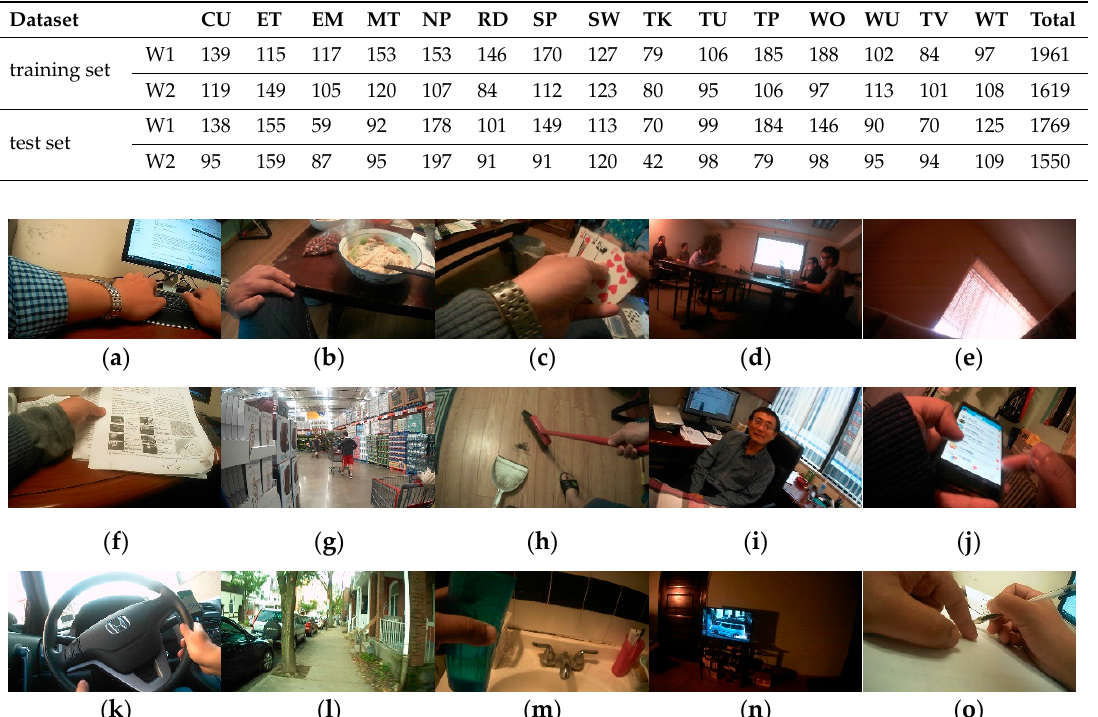
Table 3. The egocentric activities and their corresponding categories in Multimodal Dataset.